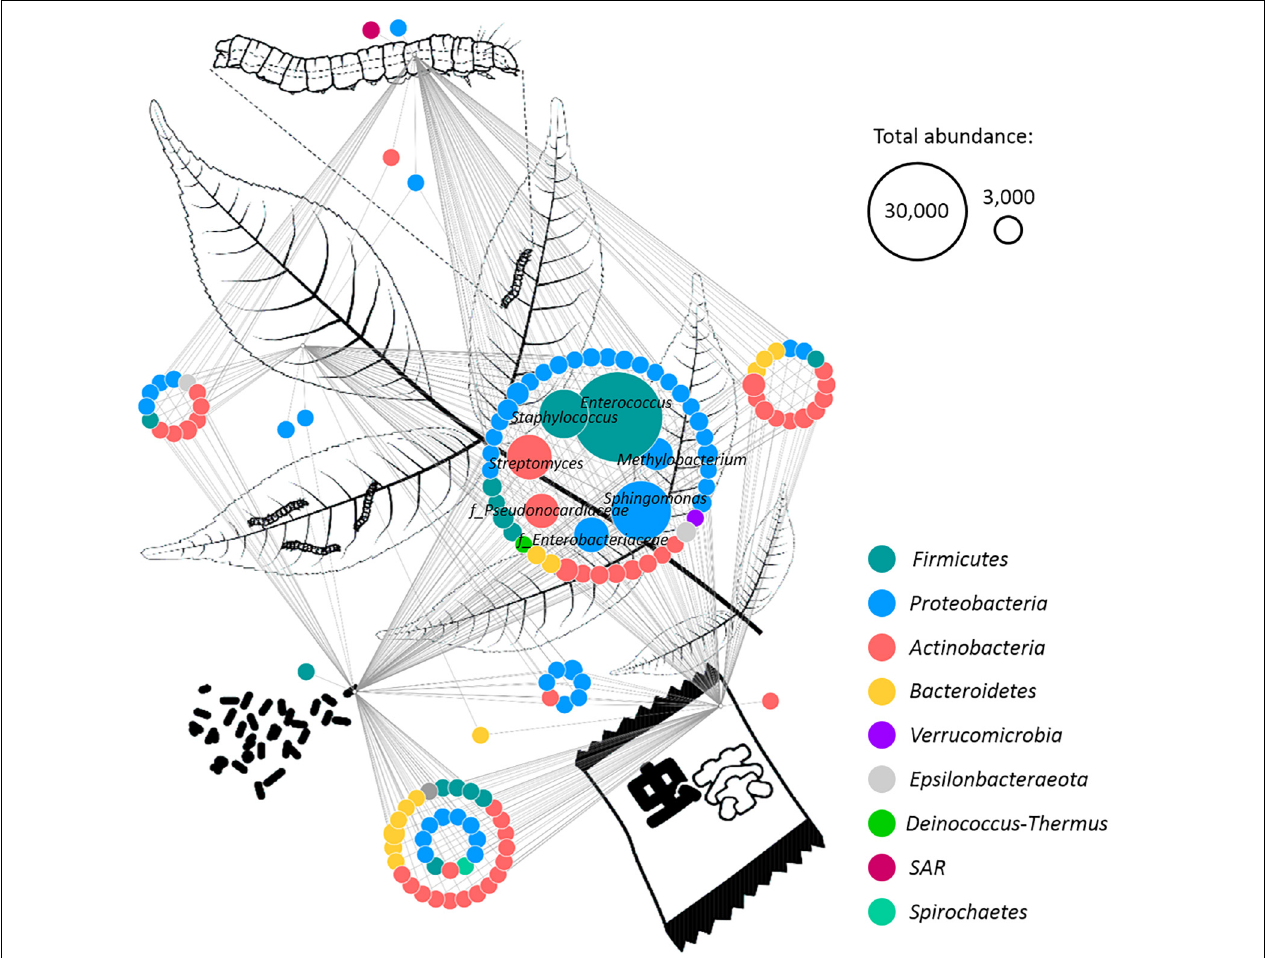
FIGURE 3 | Identification of common microbial components in different sample types. A network was rendered with Cytoscape 3.6.1 in order to identify shared bacterial taxa among different samples. The different sample types (plant leaves, insect midgut, excrements, and insect tea) are schematically visualized. Edges connect each feature with its origin, while multiple edges indicate occurrence in different sample types. The predominant features were labeled with their taxonomic assignment at family (indicated with “f”) or genus level. Node colors indicate the assignment to distinct bacterial phyla, and their size correlates with the abundance of each feature. Two representative node sizes are shown in the